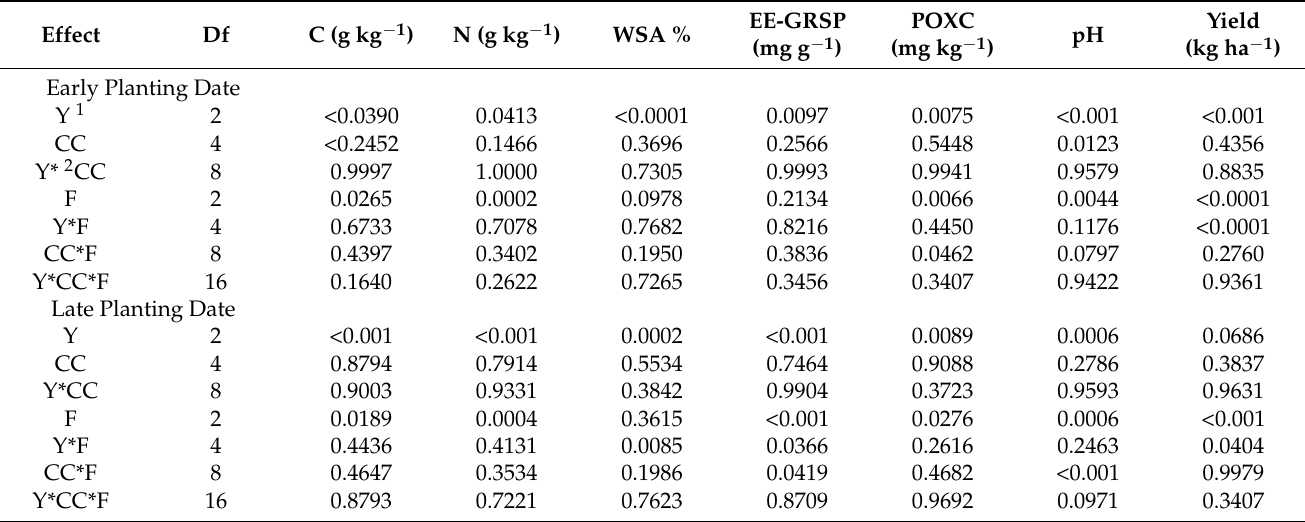
Table 5. Probability values ( p -values) and numerator of degrees of freedom (df) associated with the sources variance on soil properties and soybean yield components determined as effects of cover crop and fertilizer source in a no-tillage dryland system at Pontotoc,